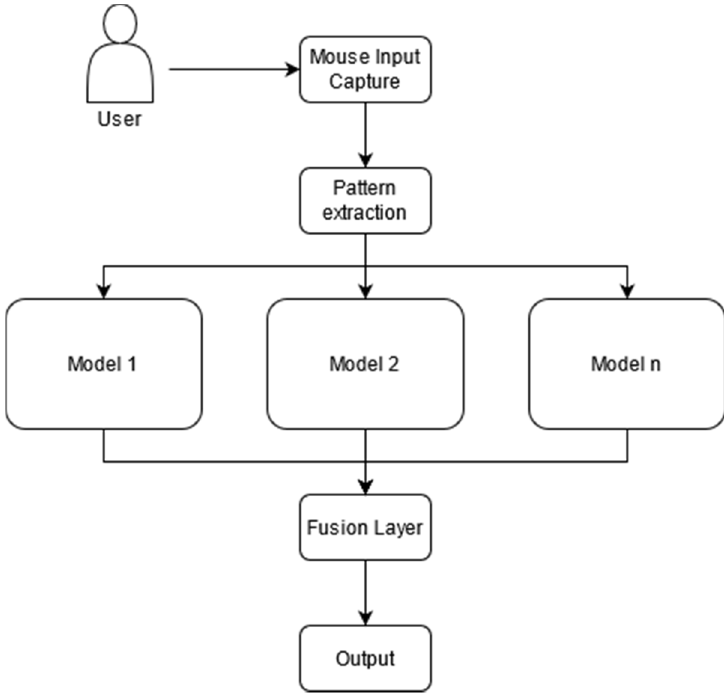
Figure 2. Proposed model for mouse behavior authentication.